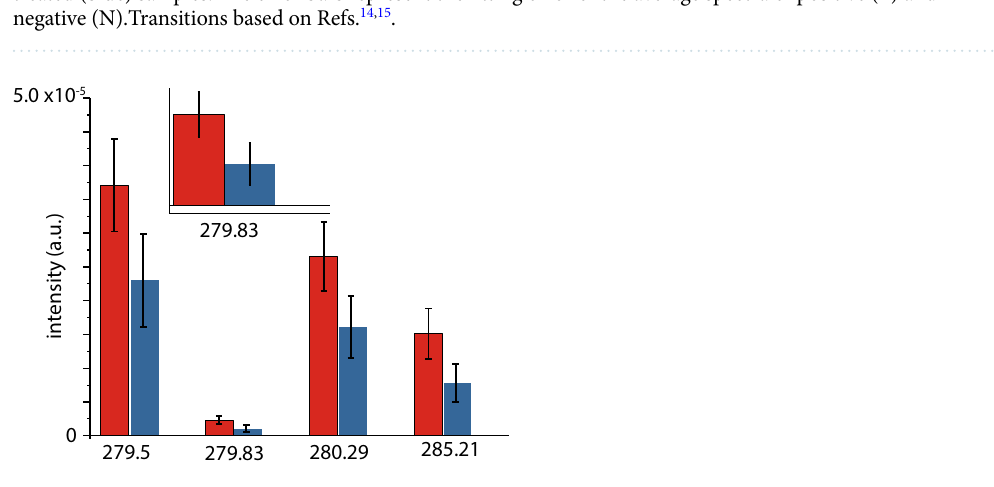
Figure 4. Comparison of the emission intensity of Mg I–II transitions in positive (red), and negative treated (blue) samples. Bars display the average between the fitted emission intensity of LIBS spectra of each individual sample, and the error bar is the standard deviation of the